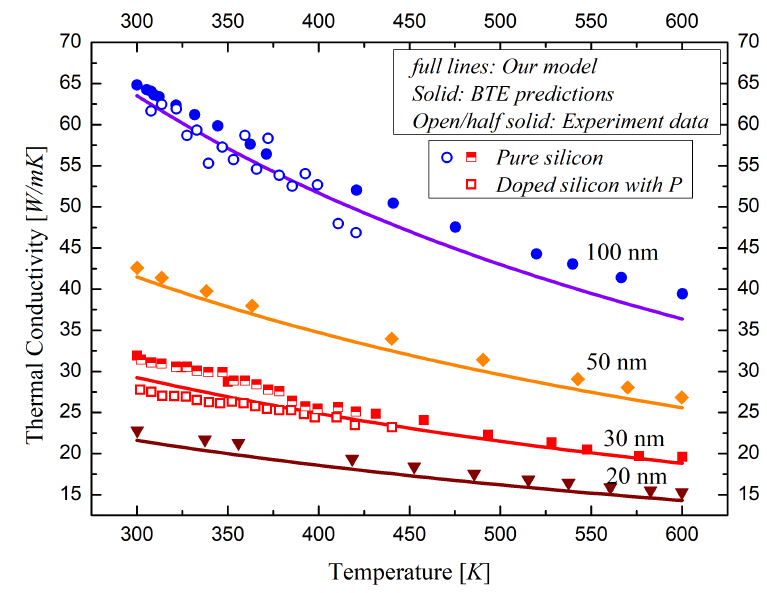
Figure 3. The temperature dependence of the thermal conductivity for FD SOI device compared with the BTEpredictions and the experimental data in previous works